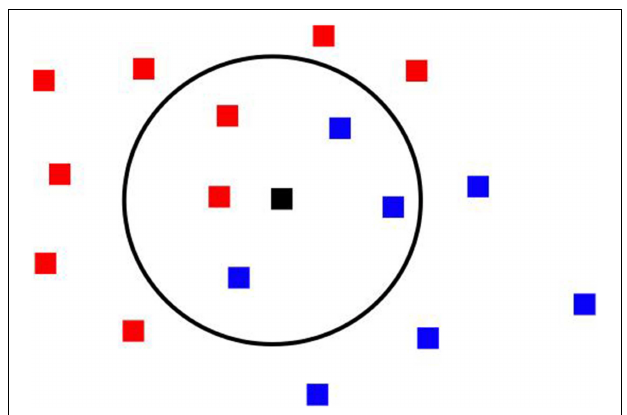
FIGURE 1 | In this k-Nearest Neighbor illustration with k = 5 , the central black square more probably belongs to the blue